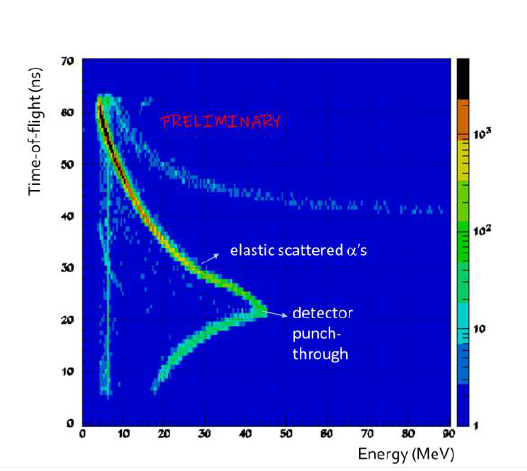
Fig. 3. Picture of 4 He gas chamber .